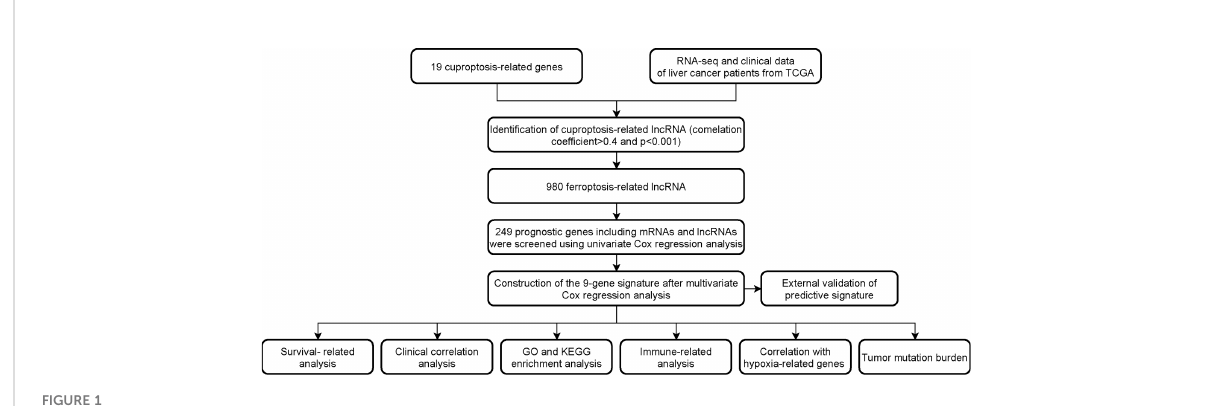
FIGURE 1 Work fl ow of the study design.